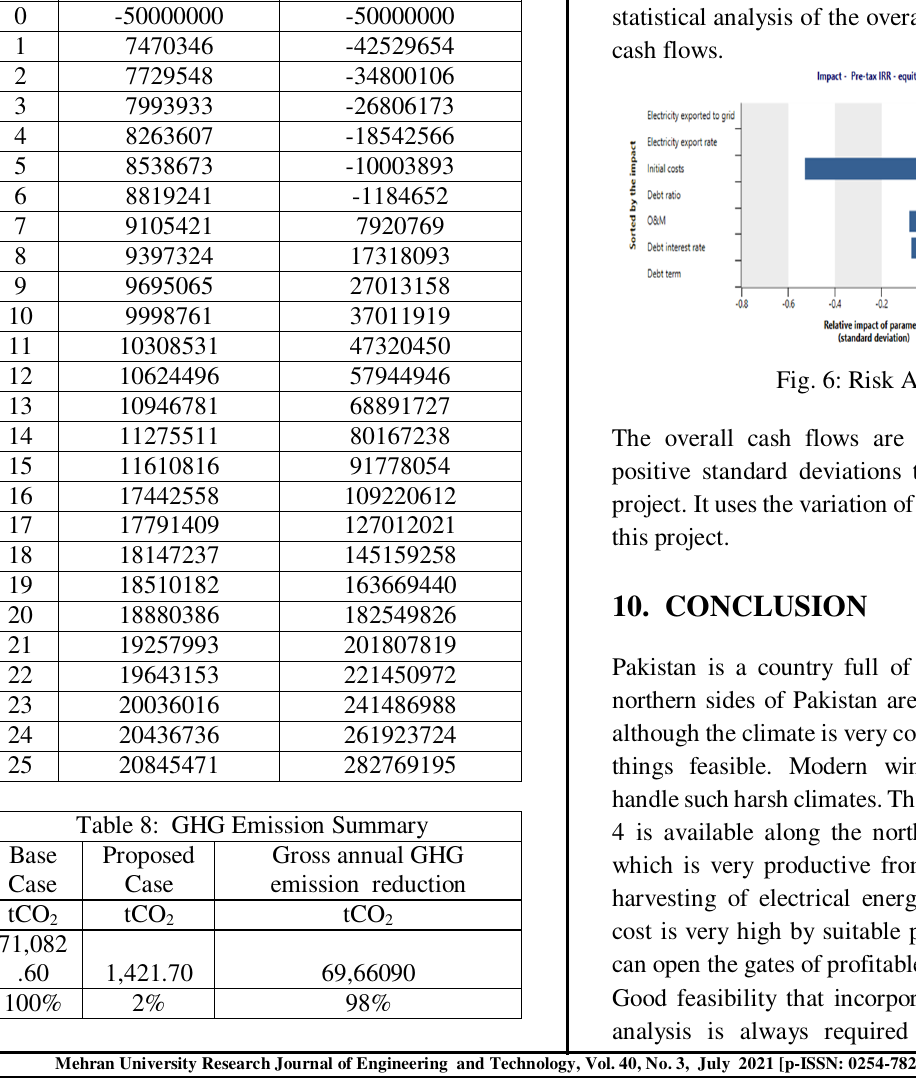
Table 7: Yearly Cash Flows